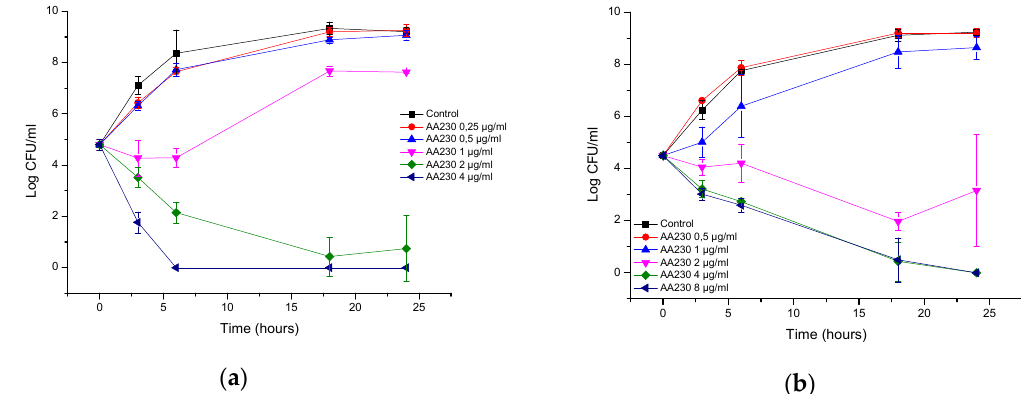
Figure 2. Time-kill curves of antimicrobial peptide AA230 against ( a ) Acinetobacter baumannii ATCC (American Type Culture Collection); ( b ) Acinetobacter baumannii RCH.